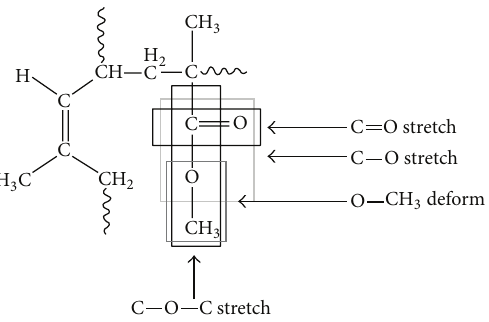
Figure 3: Isoprene/methyl methacrylate monomeric